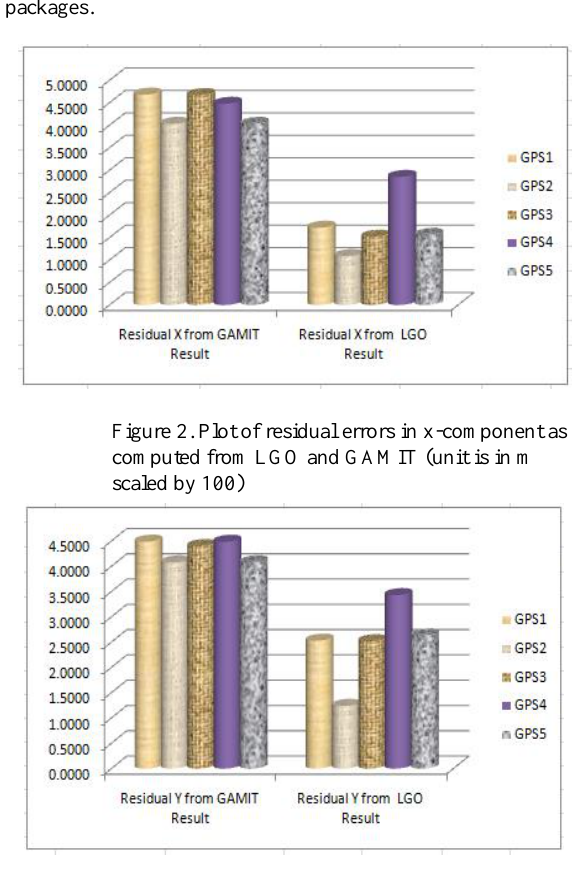
Figure 3. Plot of residual errors in y-component as determined from LGO and GAMIT (unit is in m scaled by